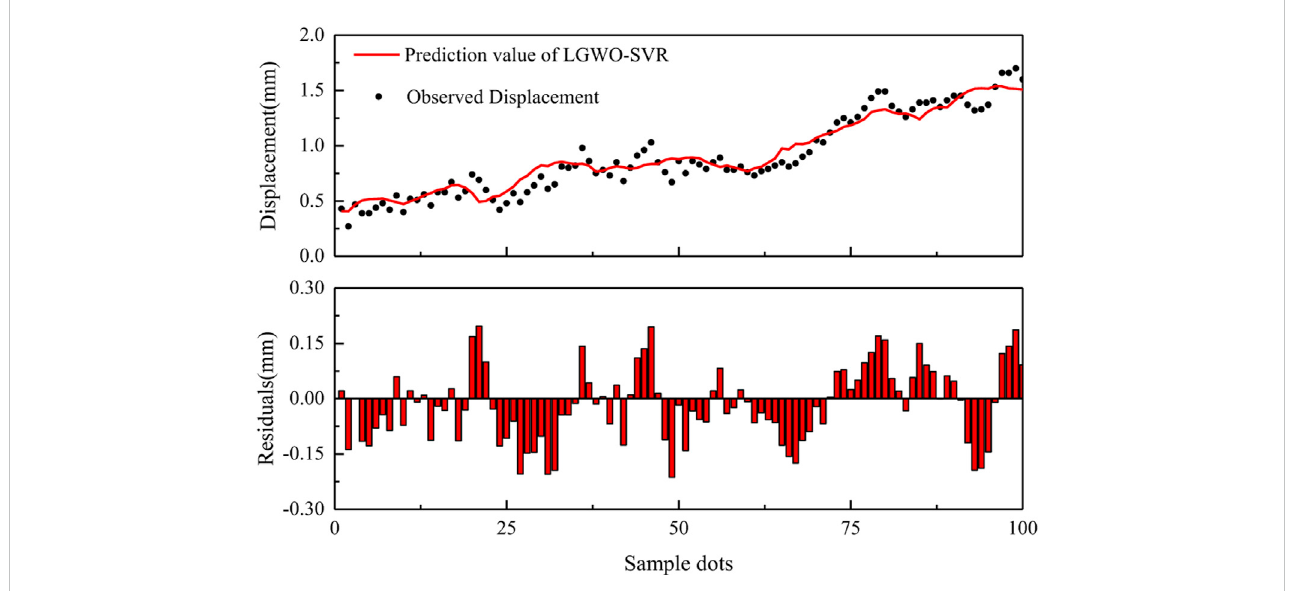
FIGURE 16 Measured and predicted displacements from the LGWO-SVR model.